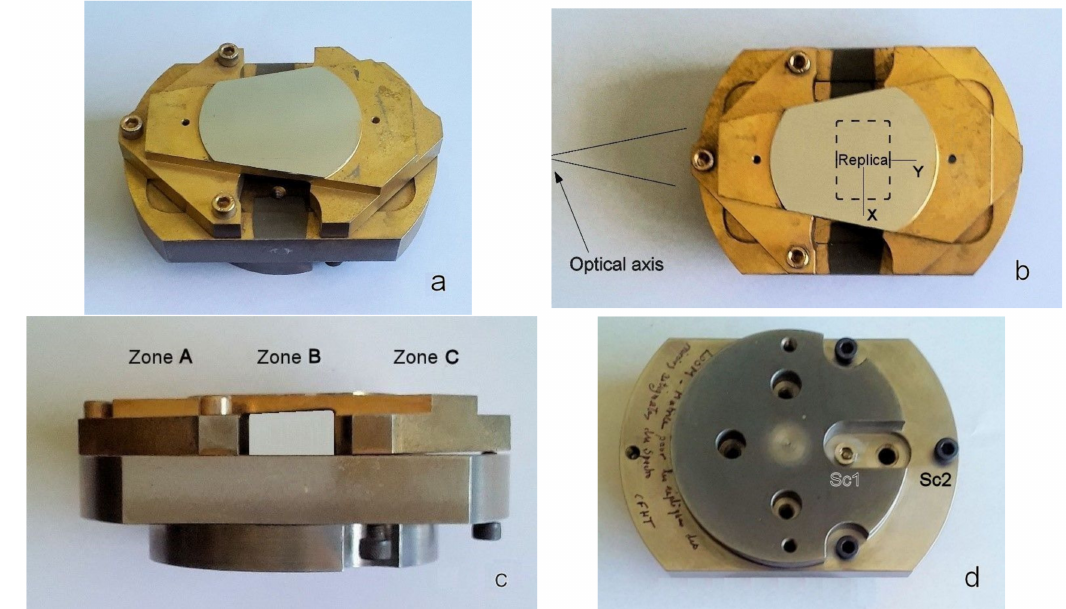
Figure 2. Various views of the deformable matrix on its bending support after removing of replica plates: oblique, front, lateral and rear views of the matrix-support system, ( a ), ( b ), ( c ), and ( d ) respectively. In ( b ), dotted lines show the 20 × 30 mm 2 replica clear aperture area which is centered at 115 mm